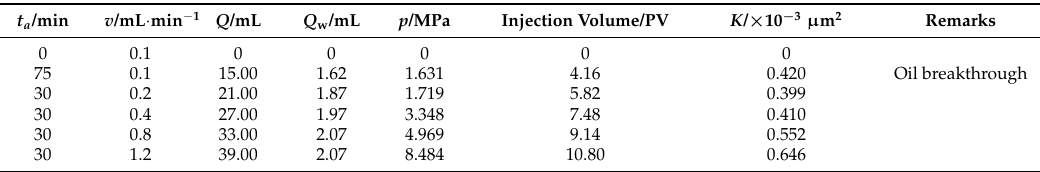
Table 5. Saturated oil experimental